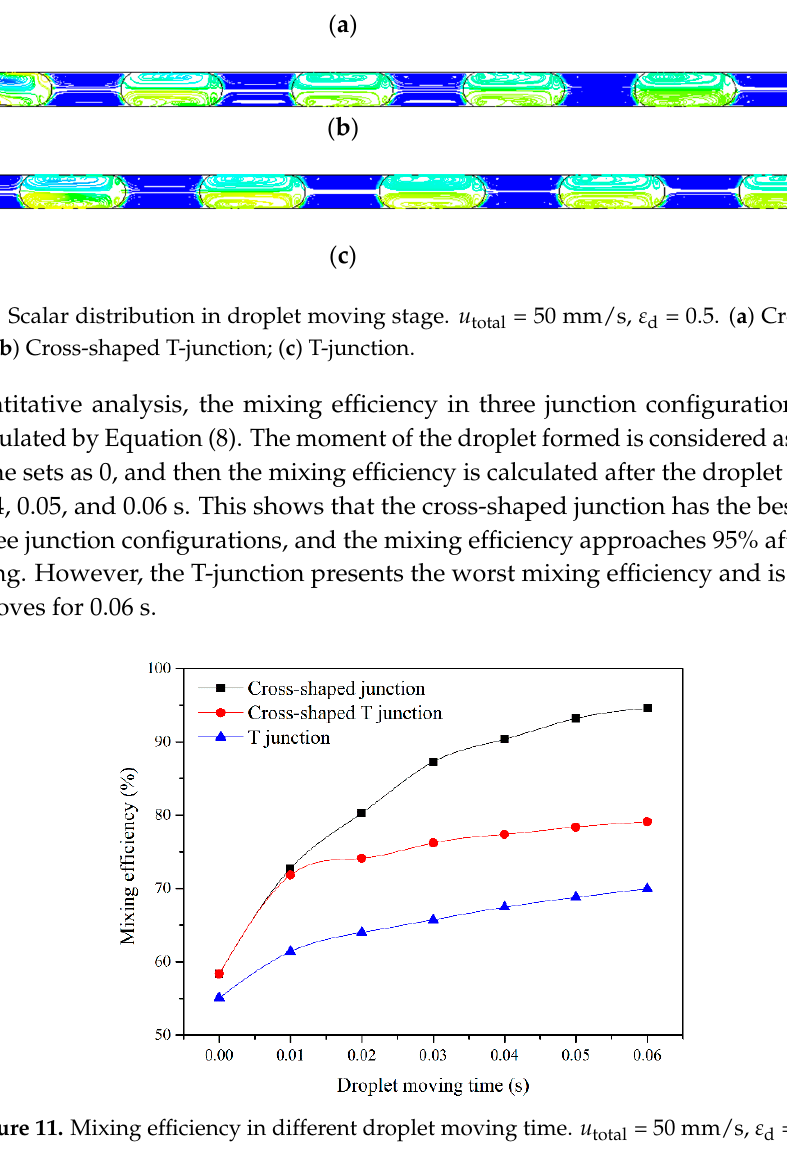
Figure 9. Mixing efficiency in different disperse phase fractions at the moment of droplet formation.